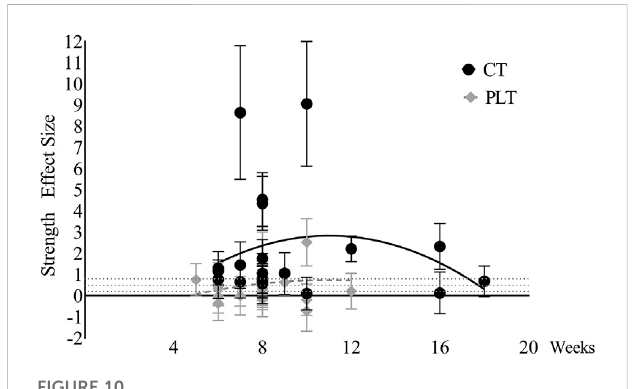
FIGURE 10 Maximum strength changes over time (CT = complex training, PLT = plyometric